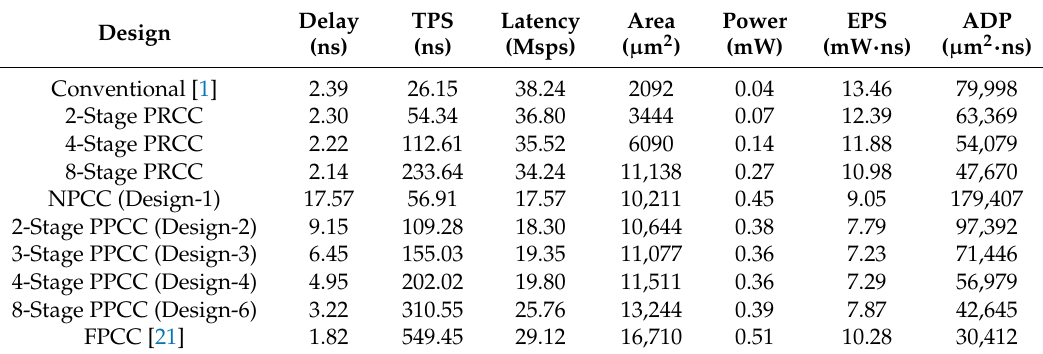
Table 4. Performance comparison of the conventional and cascaded CORDIC algorithms based on synthesis results for known rotation angles ( N = L = 16).